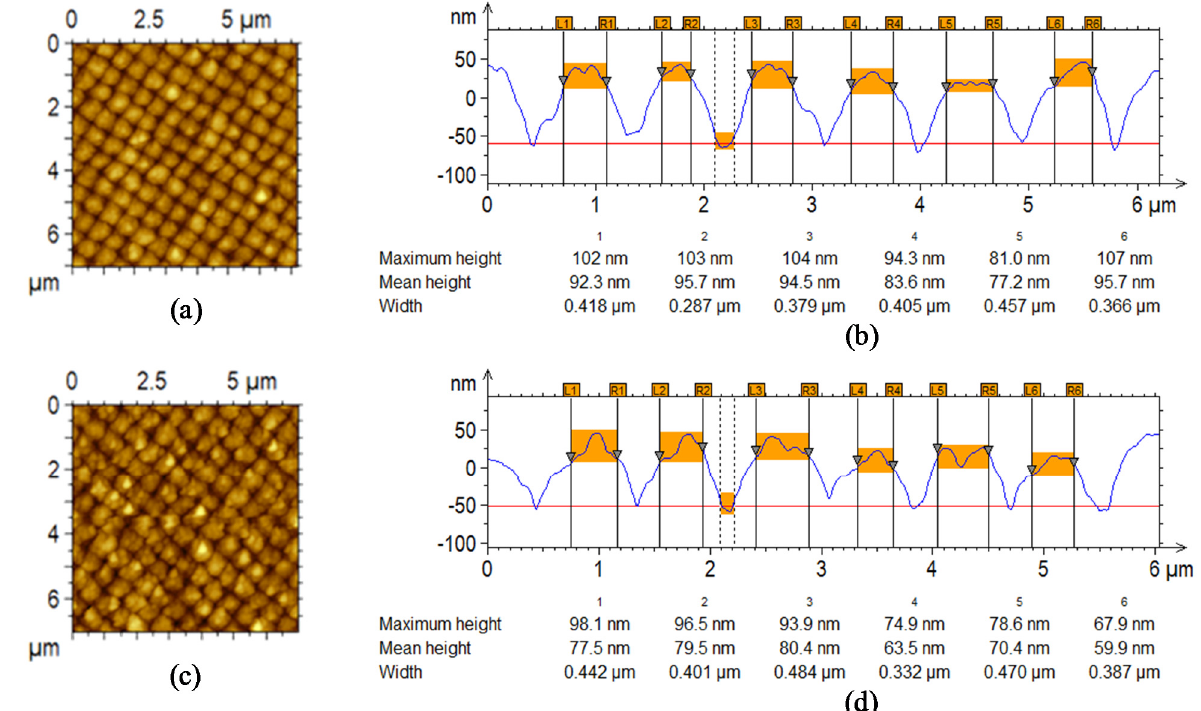
Figure 4. AFM topography images of the fabricated solar cells with cross section profile: ( a – b ) for the cell with 800-nm-thick Si stack; ( c – d ) for the cell with 1500-nm-thick Si